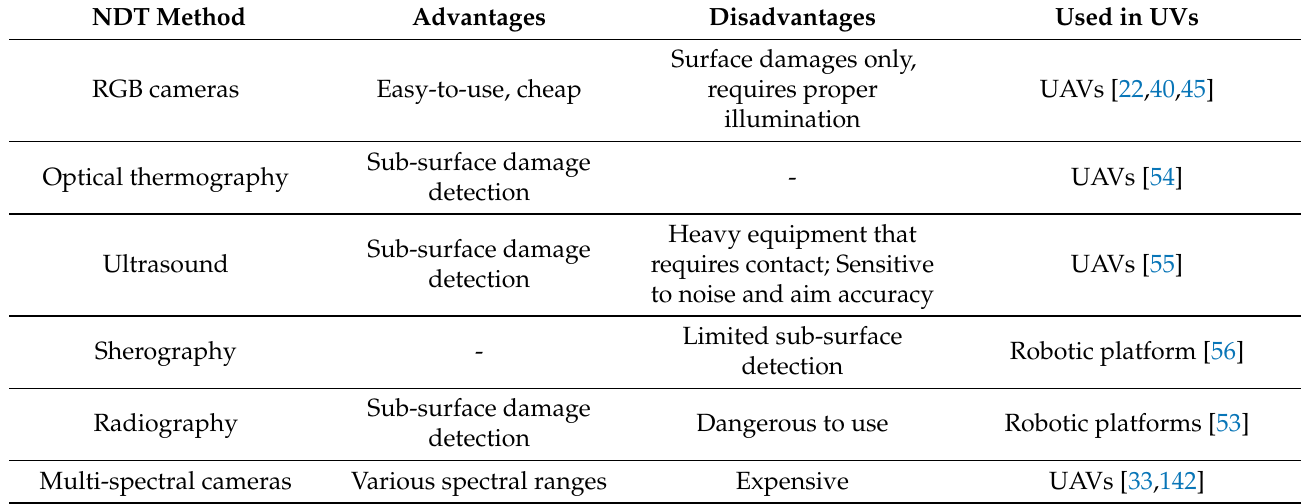
Table 1. Summary of various Non-Destructive Testing (NDT) methods for wind turbine (WT) inspections. NDT